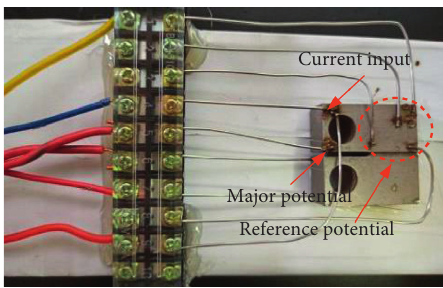
Figure 9: The position of probe